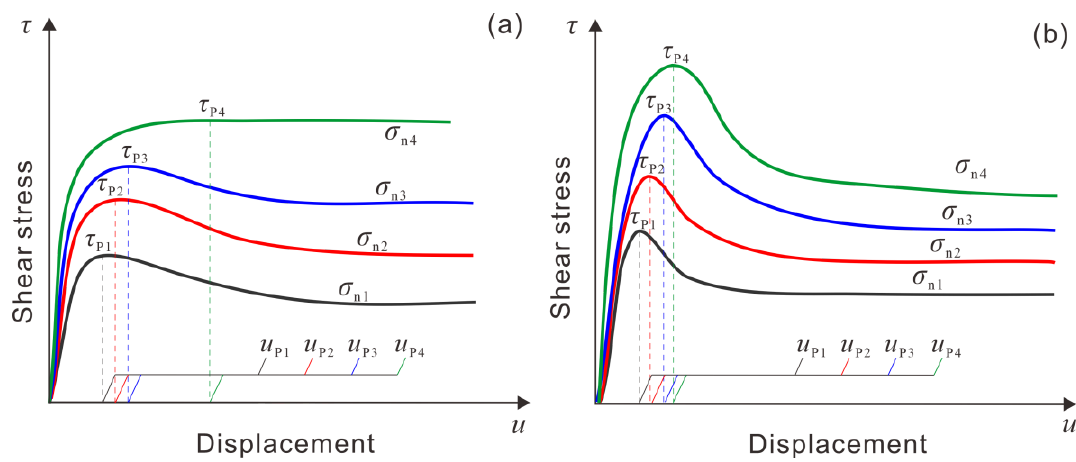
Figure 1. Two kinds of softening characteristic shear stress–shear displacement curves. ( a ) Weak softening curve; ( b ) strong softening curve; normal stress: σ n1 < σ n2 < σ n3 < σ n4 .